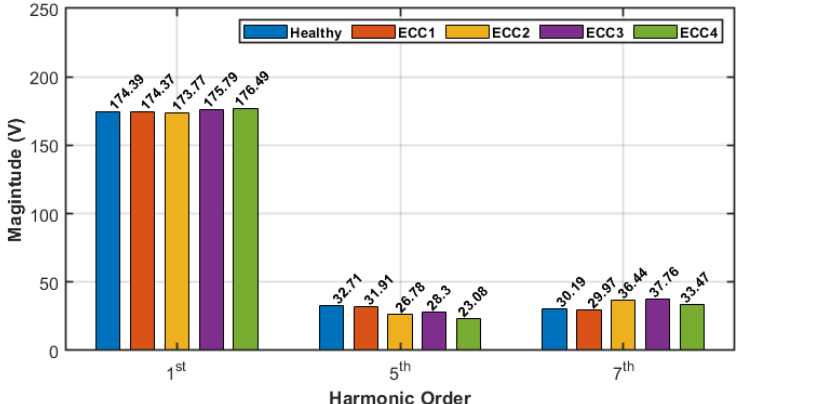
Figure 17. Variations in the harmonic content of stator voltage spectrum for healthy and faulty machine under eccentricity fault in DTC drive.